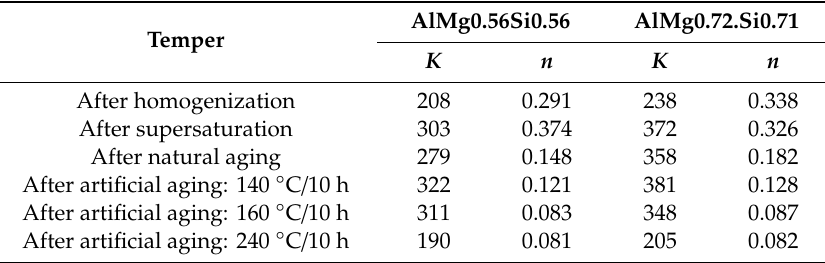
Table 5. Values of the K and n coe ffi cients according to Hollomon’s equation for Al-Mg-Si wire rods after di ff erent types of heat treatments. AlMg0.56Si0.56 Temper After